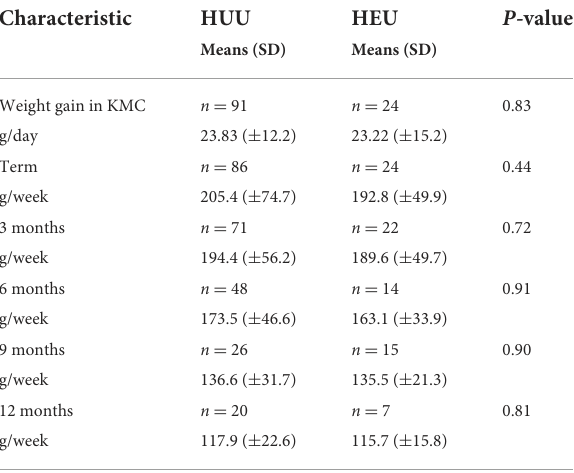
TABLE 3 Growth velocity in KMC and at term, 3, 6, 9, and 12 months.